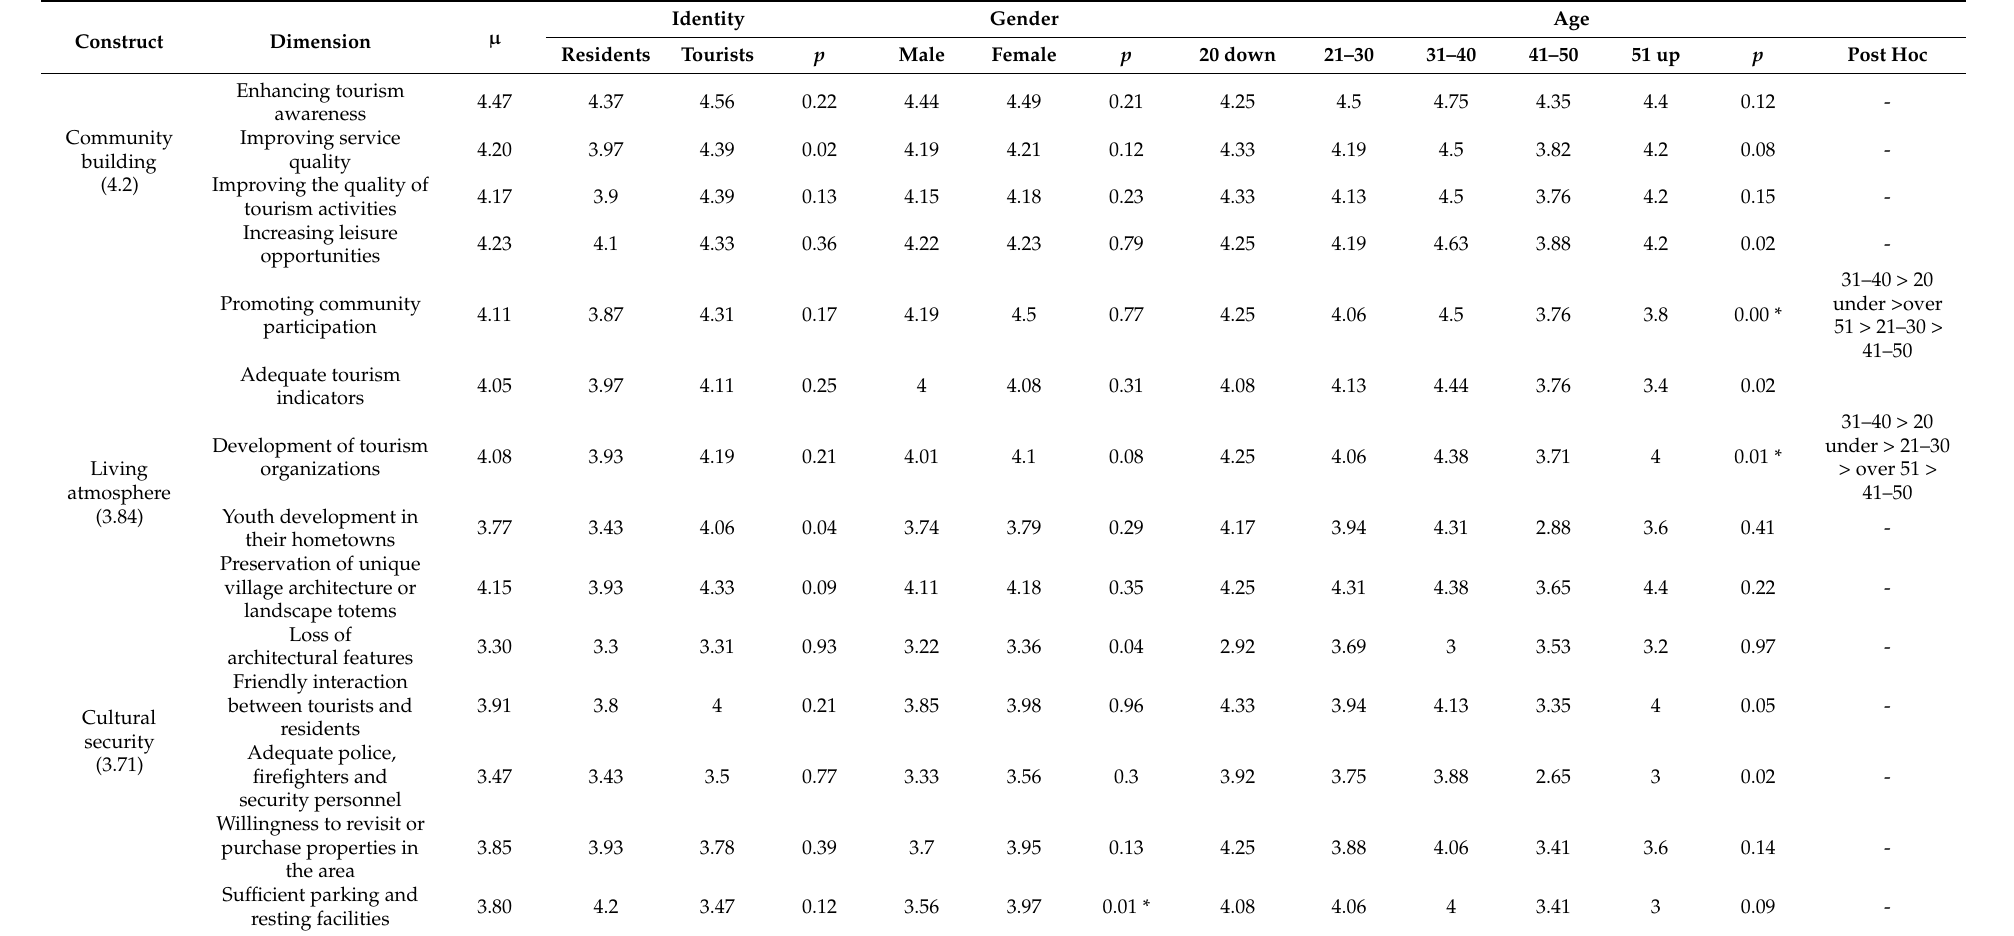
Table 5. Analysis of the awareness of the impact of religious and cultural tourism on village